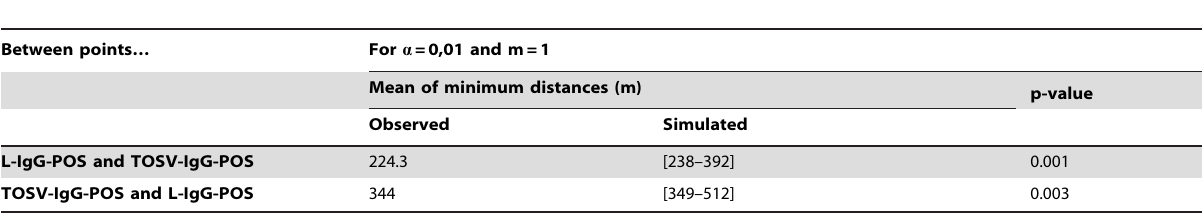
Table 3. Results of the spatial co-location test including the intrinsic correlation.